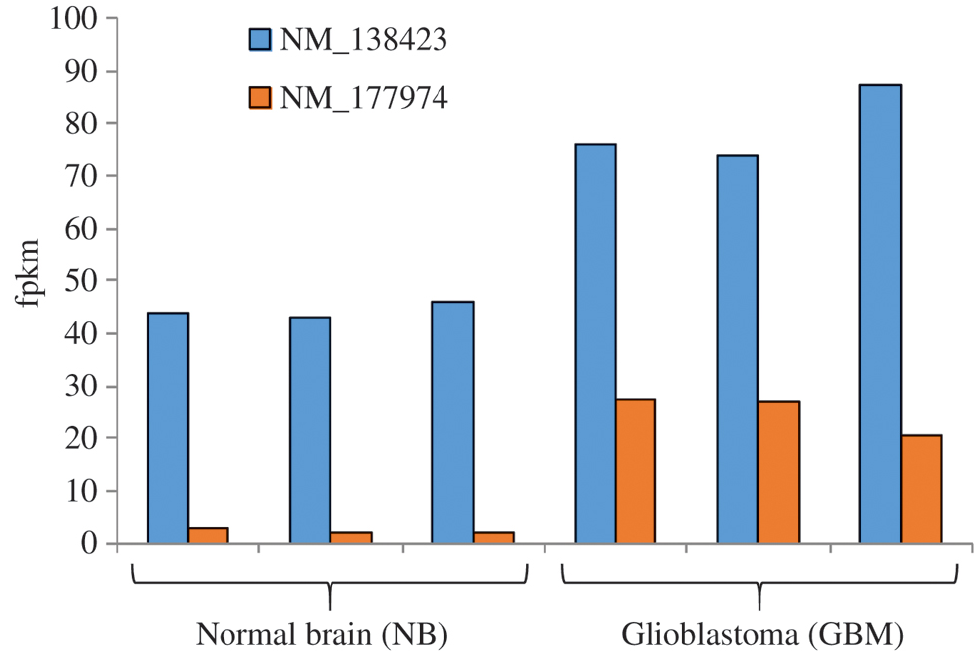
Figure 4: Distributed isoforms expression of CASC4 gene measured by fpkm values calculated by cuffnorm application. The short isoform (NM_177974) is expressed about 6 fold higher in GBM cells, while the longest isoform (NM_138423) maintains increased expression as